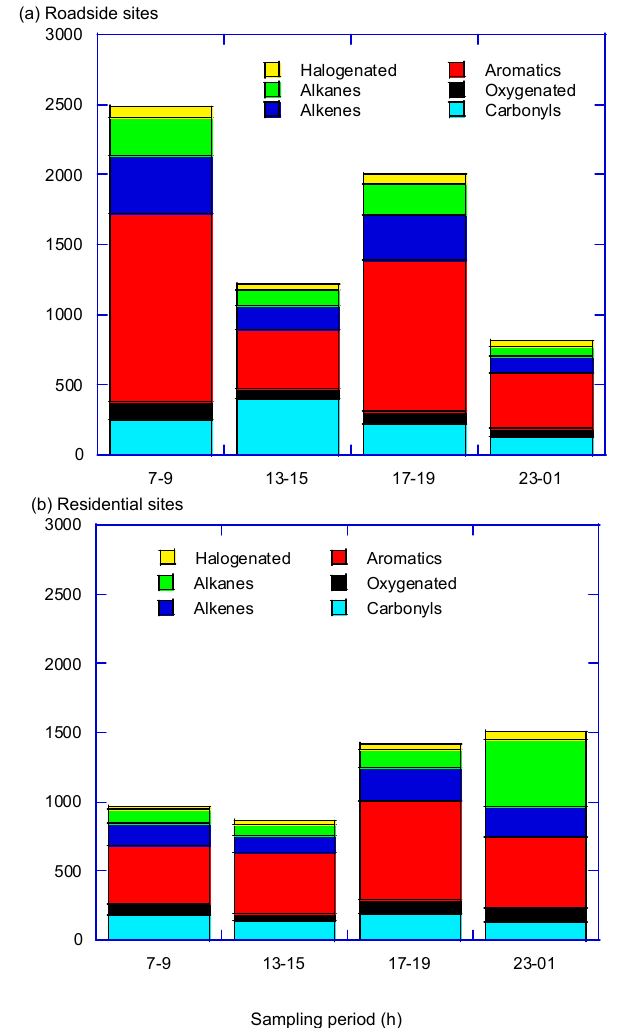
Figure 3. Ozone formation potential of VOC groups at roadside and residential sites for different sampling periods. ( a ) Roadsite sites, ( b ) Residential sites.